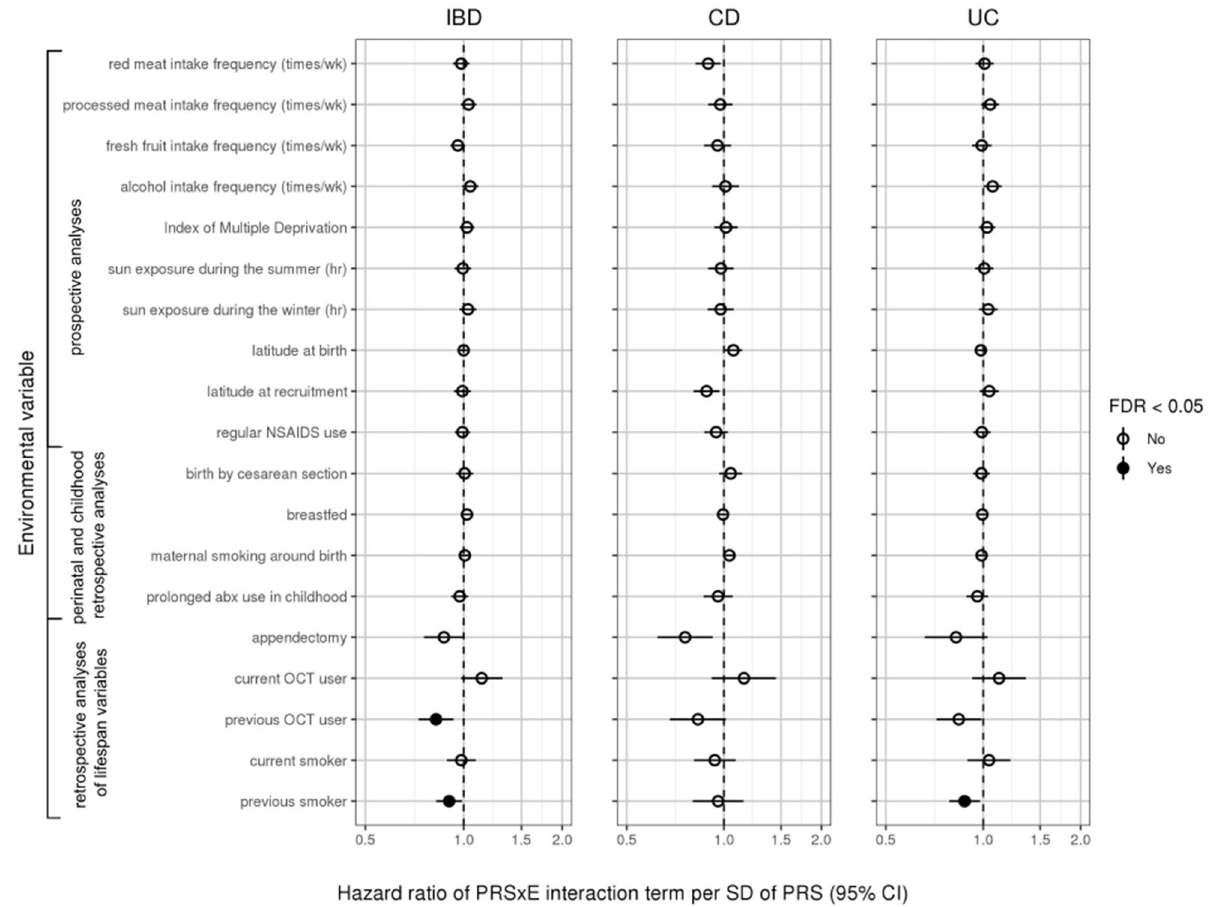
Figure 5. Forest plot of hazard ratios (dots) and 95% confidence intervals (lines) for PRSxE interactions obtained from Cox regressions. Hazard ratios were adjusted for other covariates, including polygenic risk. Statistically significant results (FDR < 0.05) represented by filled circles. x-axis truncated at 2. For continuous variables, hazard ratios are given per standard deviation of the variable per standard deviation of PRS. For binary variables, hazard ratios are given per standard deviation of PRS. Results for 24-h dietary variables are shown in Supplemental Fig. 4. Results for hormone replacement therapy not displayed because they did not meet the proportional hazards